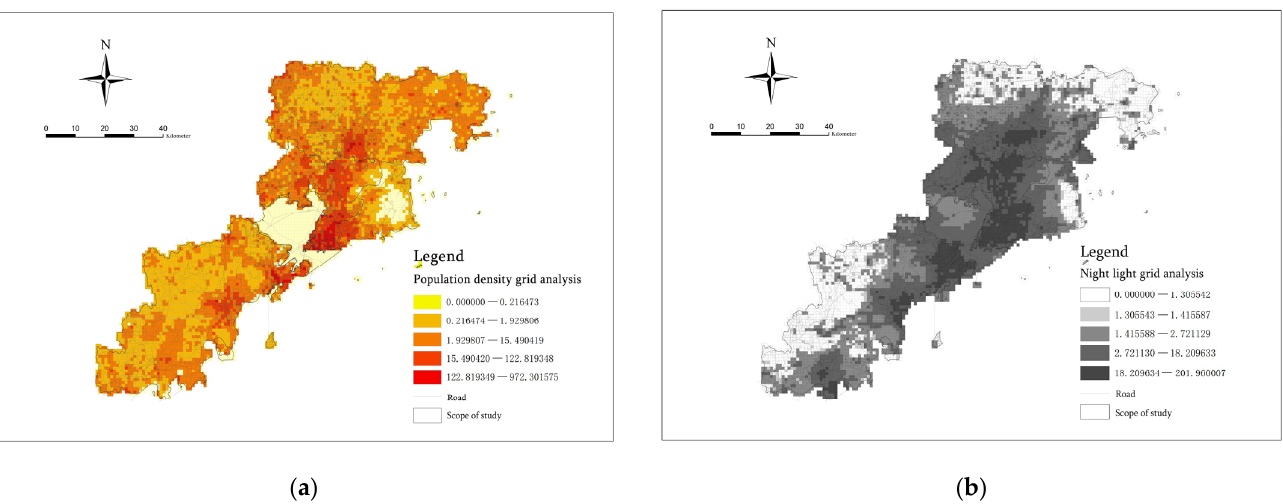
Figure 6. ( a ) Population density index and ( b ) Night light